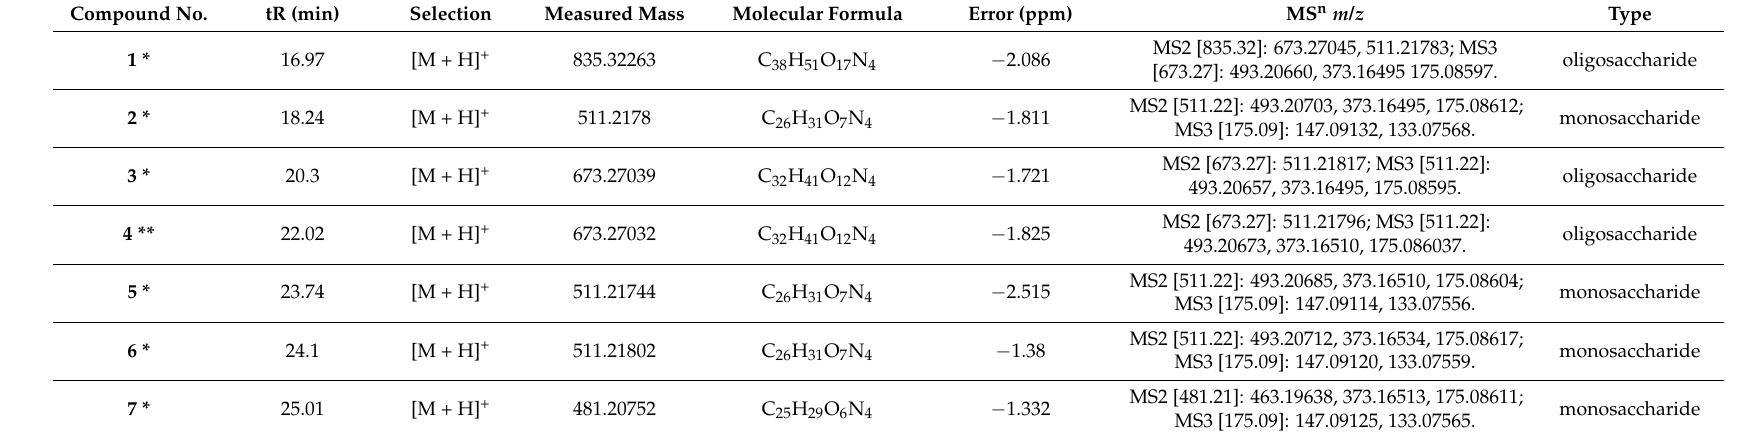
Table 1. MS n data and fragmentation pathways for the compounds identified from four different processed RRs.